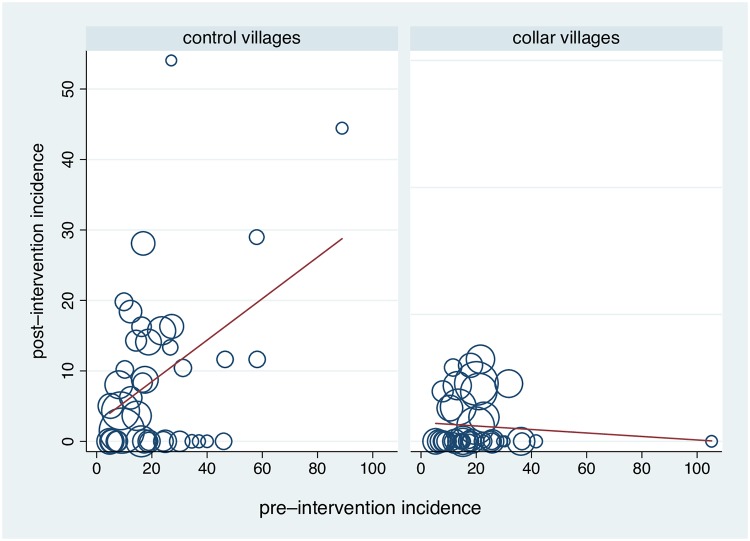
Association between the pre–and post–intervention incidence per 1000 in the 40 control and 40 collar villages.Line: least squares linear fit from regression of the post–intervention incidence against the pre–intervention incidence, weighted by number of children in the denominator (symbol size).